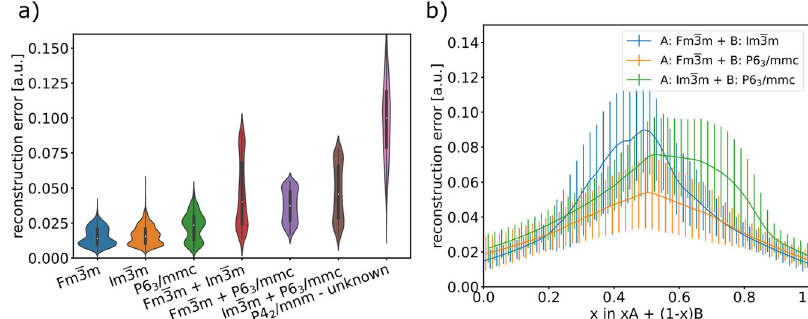
Fig. 3 VAE reconstruction error of phases and phase mixtures. a Violin plot showing the statistics of the reconstruction error for pure phases, two-phase mixtures and an unknown pure structure. The median of phase mixtures is signi fi cantly higher than for pure phases. The median of the unknown phase shows a one order of magnitude increase in reconstruction error with respect to pure phases. Pure phases show a multimodal distribution, phase mixtures a bimodal distribution and the unknown phase a normal distribution. A broader distribution is observed for phase mixtures and the unknown phase. b Reconstruction error versus mixing ratio of binary mixtures. The reconstruction error shows a maximum at appr. 50% mixture for which the VAE has the highest uncertainty. We suggest that the reconstruction error be used as a metric for uncertainty that indicates XRD patterns that are either mixtures of phases or new phases that are not contained in the training data. The reconstruction error could be used to guide a data-driven acquisition function in the search for single phase regions in large chemical composition spaces and the discovery of new